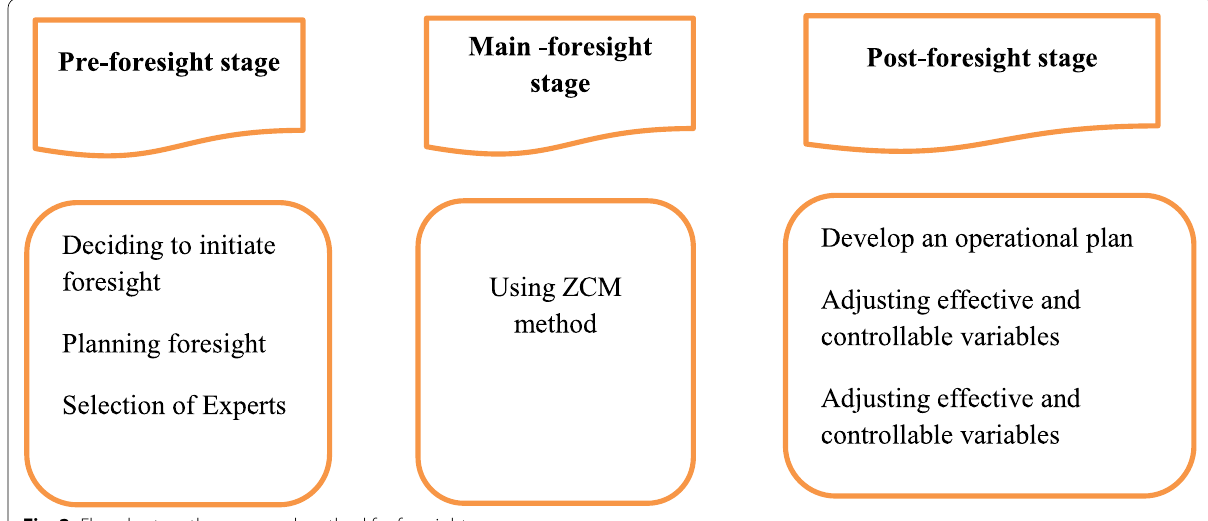
Fig. 2 Flowchart on the proposed method for